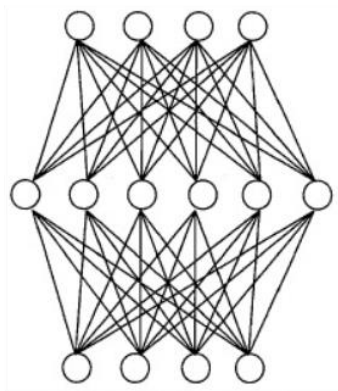
Figure 6. Schematic of a single hidden layer neural network.